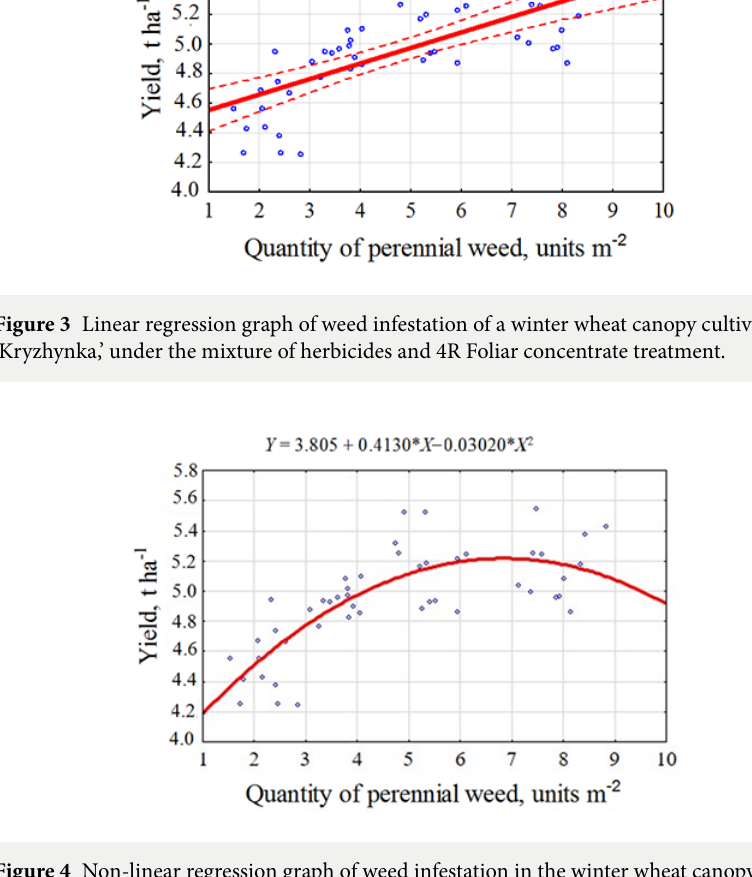
Figure 4 Non-linear regression graph of weed infestation in the winter wheat canopy cultivar, ‘Kryzhynka,’ under the mixture of herbicides and 4R Foliar concentrate